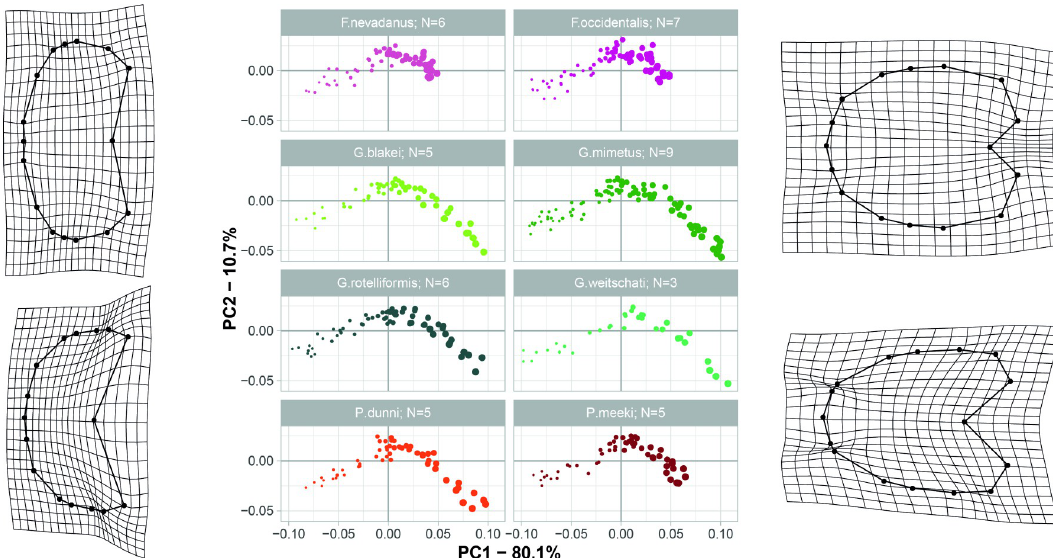
Fig 4. Developmental morphospace with PCA of un-weighted Procrustes shape variables. Point size refers to growth stage. Deformation grids show the transformation of the mean shape to the modeled shapes of the extreme values for PC1 and PC2.